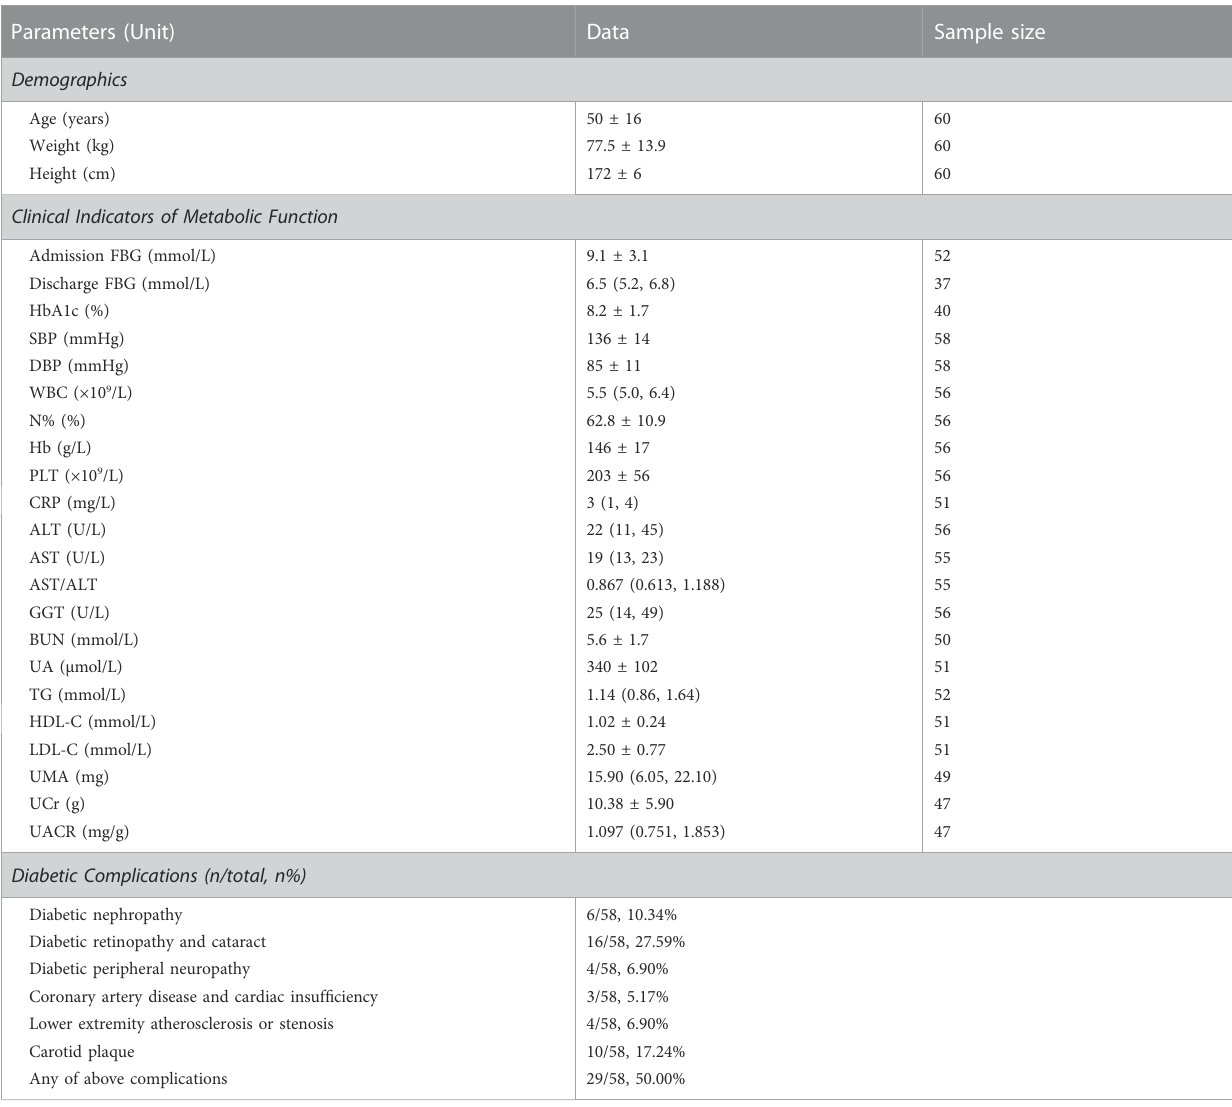
TABLE 1 Characteristics of the study cohort. Data are presented as mean ± standard deviation (SD) if the variable is normally distributed, otherwise presented as median (p25,